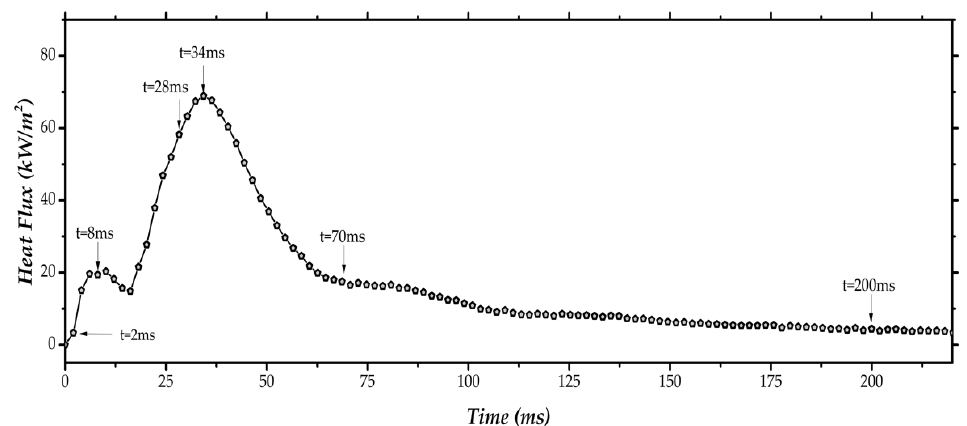
Figure 9. Heat flux removed by the spray averaged within the entire wetted area obtained for DI water spray at z = 10 mm.